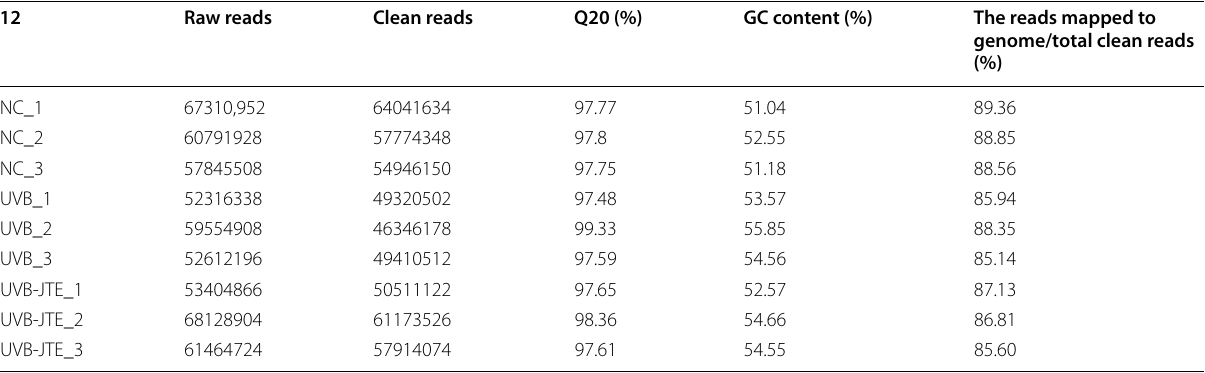
Table 3 The statistics of RNA-sequencing results*